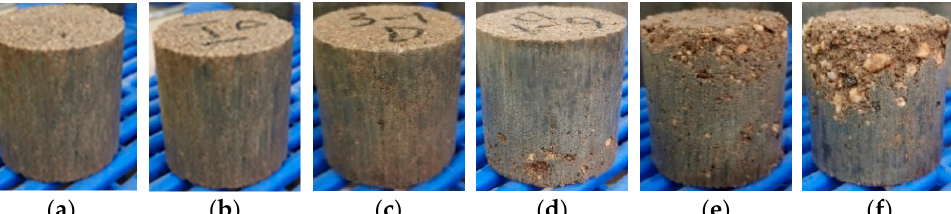
Figure 4. Effect of freeze–thaw cycles on specimen appearance. ( a ) N = 0, ( b ) N = 1, ( c ) N = 3, ( d ) N = 6, ( e ) N = 9, ( f ) N = 12.